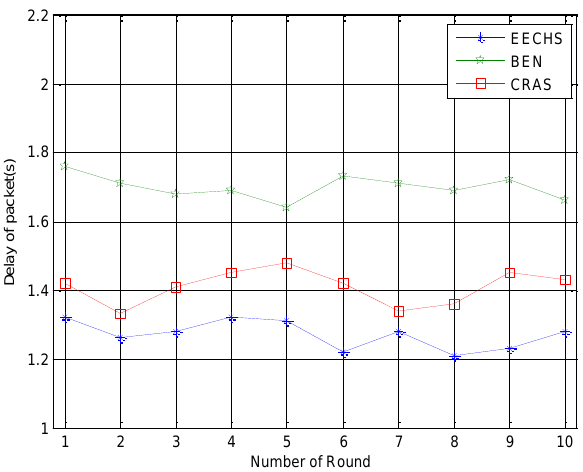
Figure 7. Experimental results for the packet loss ratio.